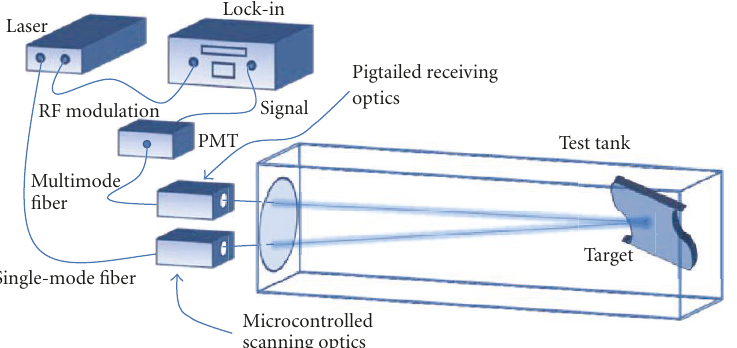
Figure 2: Experimental set-up of the bistatic AMULOR system realized at the ENEA Artificial Vision Laboratory in Frascati. In polarimetric experiments, both the launching and receiving stages are additionally equipped with a Glan-Thompson polarizer and a wave quarter plate, not reported in the figure.